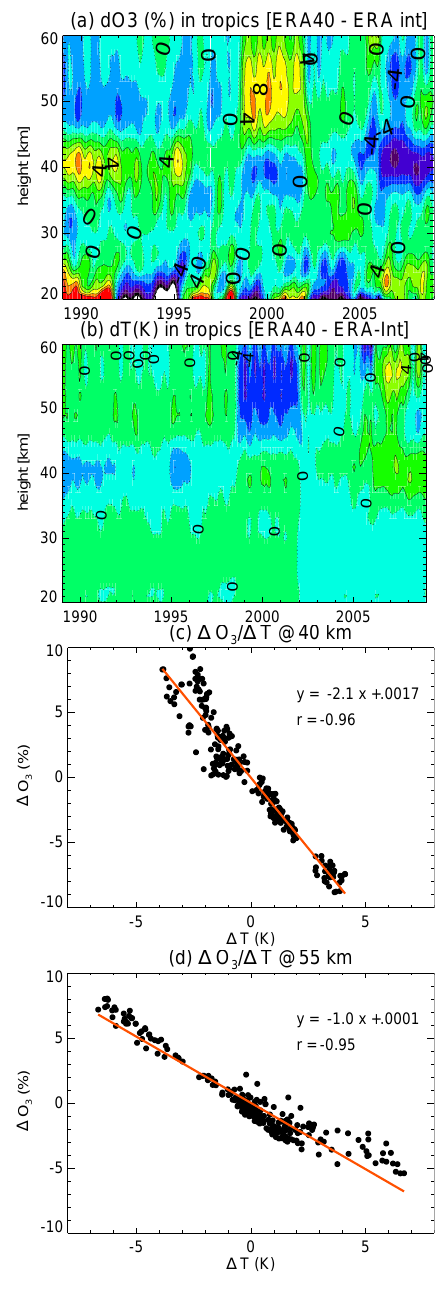
Fig. 3. Differences between tropical (25 ◦ S–25 ◦ N) (a) simulated ozone (in %) and (b) temperature (K). These are calculated as run A E40 minus run B EI for ozone and ERA-40/operational minus ERA-Interim for temperatures. Contour intervals are 2% for O 3 and 2K for temperature. Positive (green to red colours) and negative (blue to violet colours) differences are shown with solid and dashed lines, respectively. Positive contours in (a) , indicate more ozone in run A E40 whereas ones in (b) , indicate warmer temperatures in ERA-40. Scatter plots of differences in O 3 (%) and differences in T (K) for run A E40 minus run B EI at (c) 40km and (d) 55km.